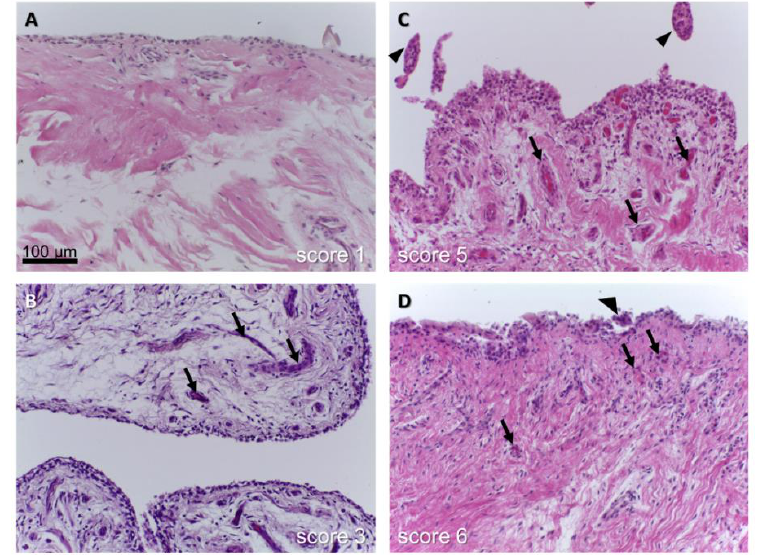
Figure 3. Synovitis of the synovial membrane covering the human ACL in osteoarthritis (OA). The score reported by Berger et al., [82] was used. ( A ): Unchanged synovial sheath, ( B ): slightly, ( C , D ): inflamed synovium with hypervascularization. (arrows: vessels, arrow head: villus).